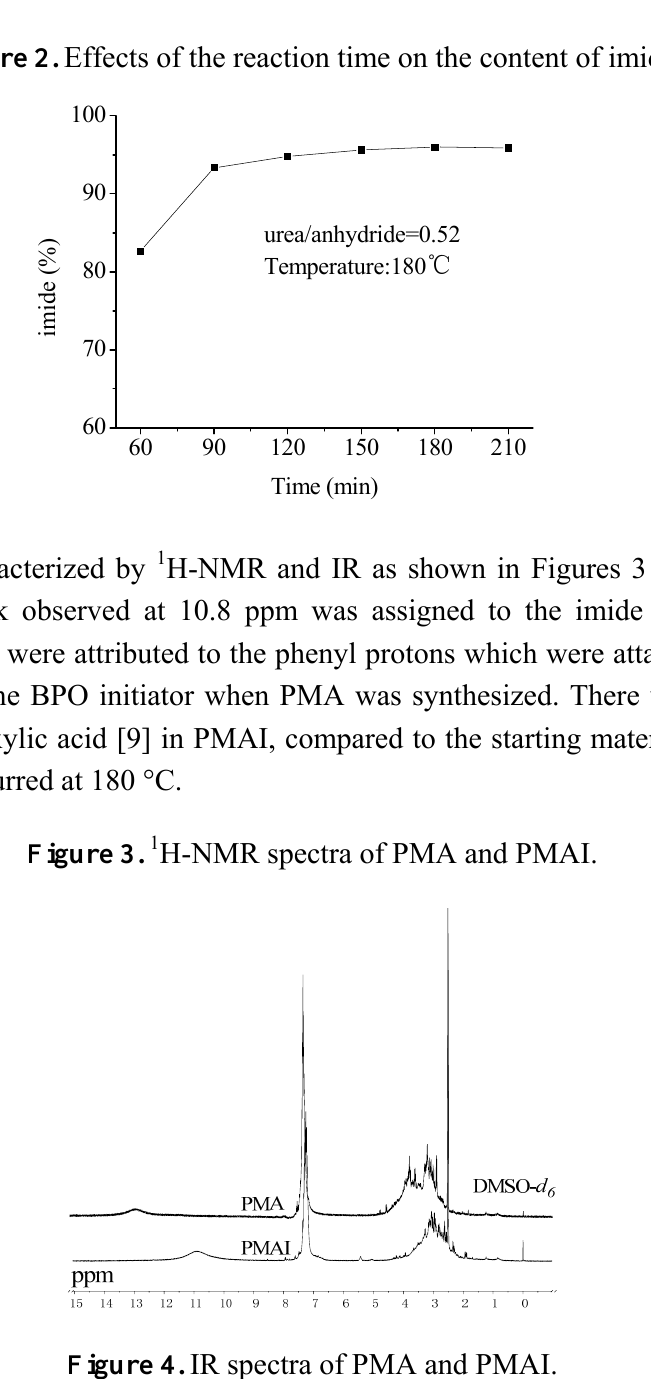
Figure 4. IR spectra of PMA and